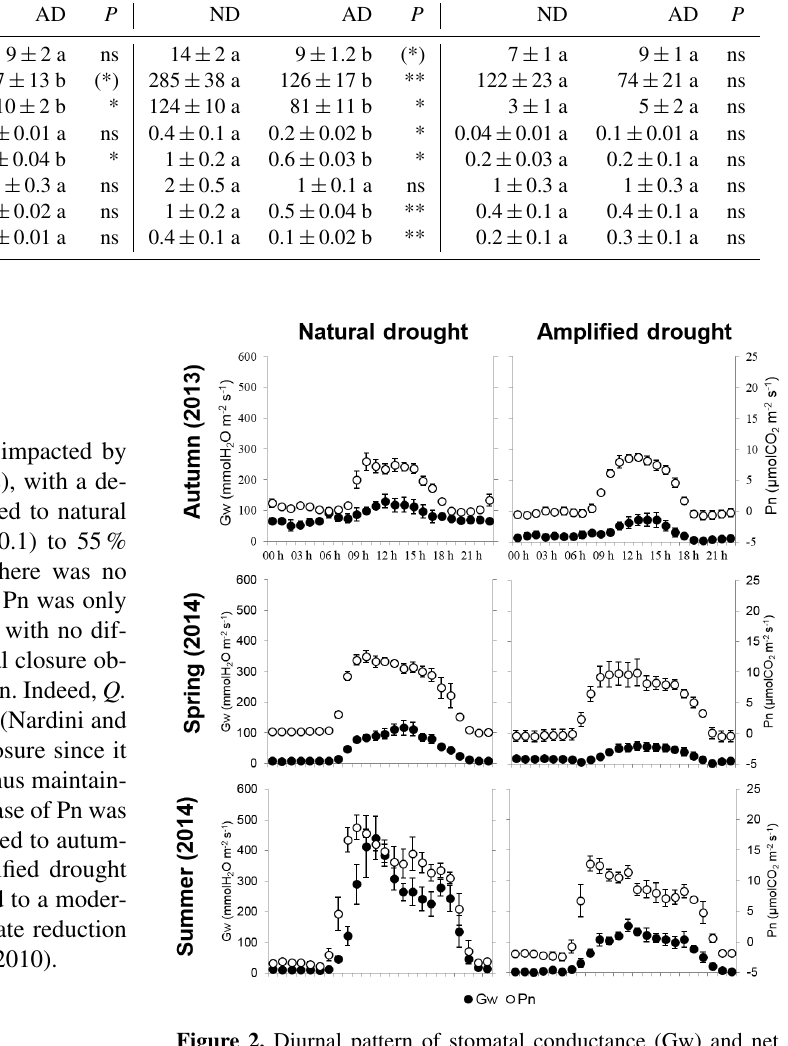
Figure 2. Diurnal pattern of stomatal conductance (Gw) and net photosynthesis (Pn) according to drought treatment and season. Val- ues showed represent means ± SE, n =